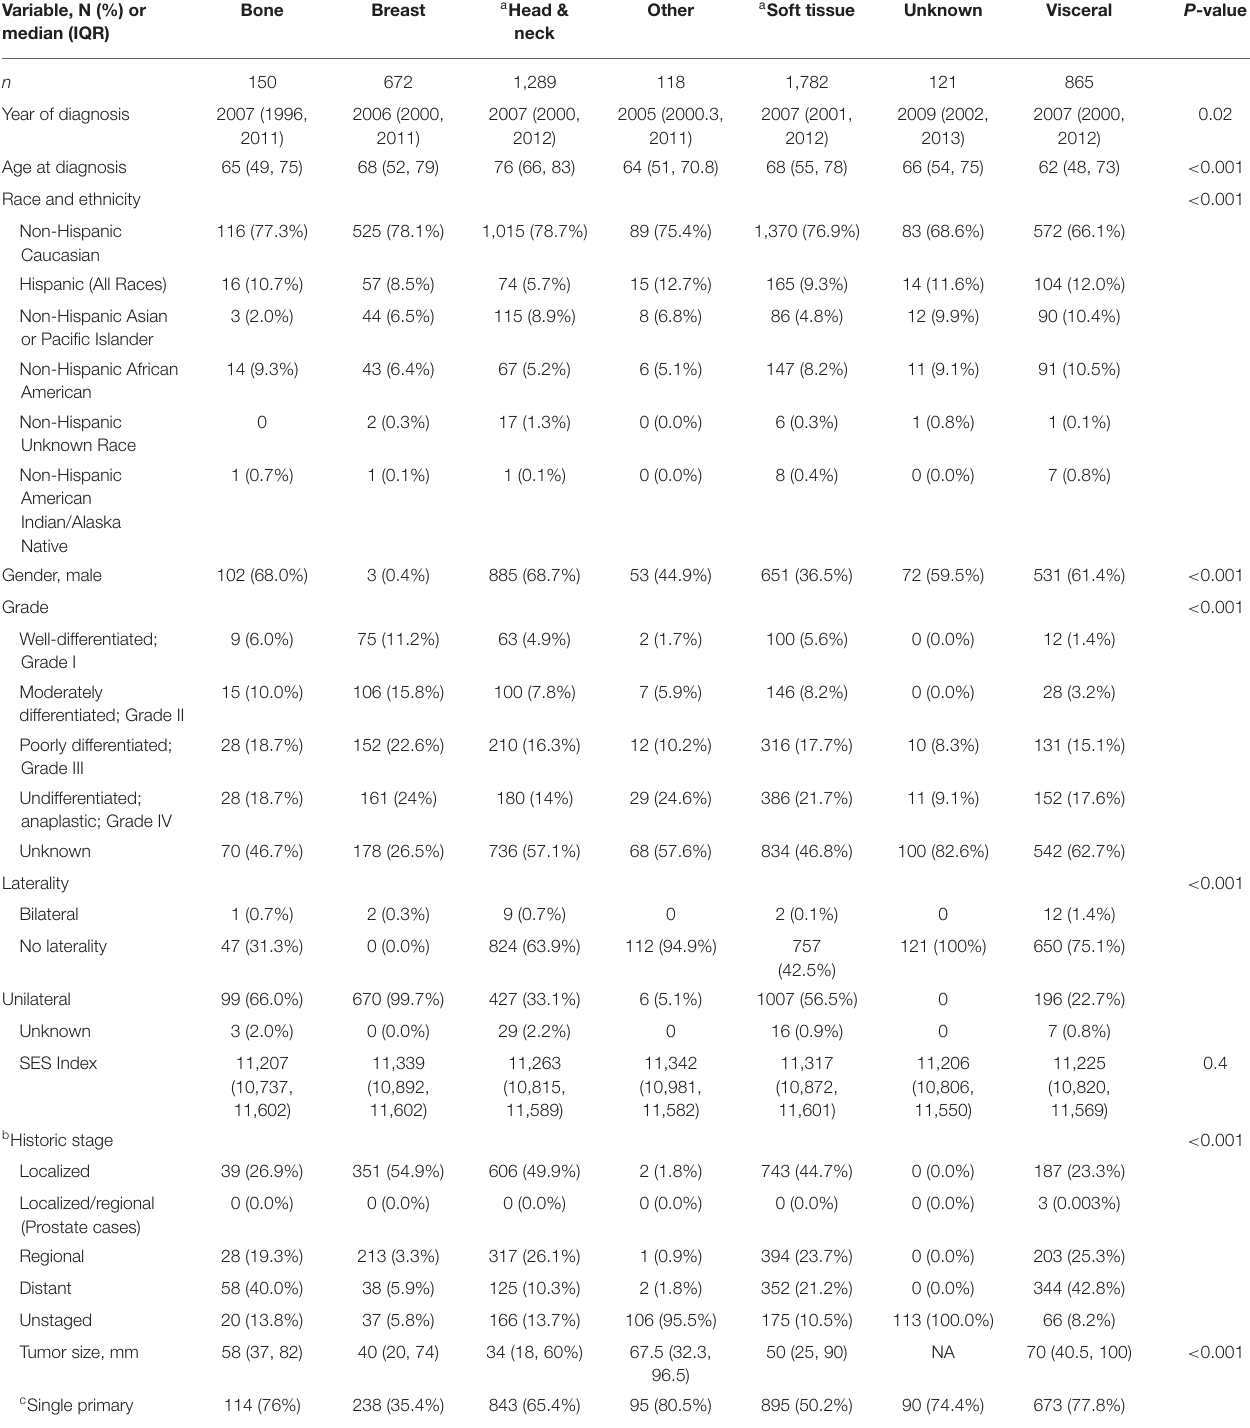
TABLE 2 | Comparison of patient demographics, tumor characteristics, treatment by tumor primary site, all angiosarcoma in SEER database, 1975–2016. Variable, N (%) or Bone Breast a Head & Other a Soft tissue Unknown Visceral P median (IQR) neck